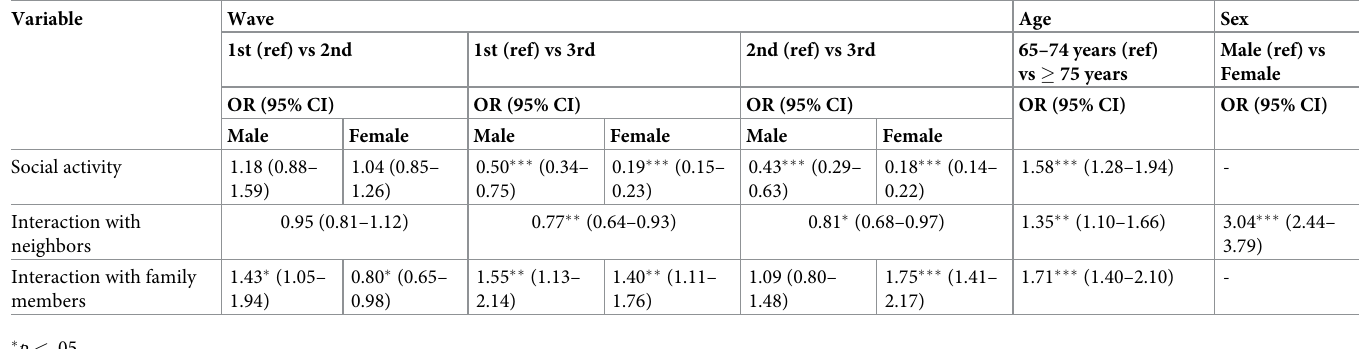
Table 2. Odds-ratio estimations from the generalized linear mixed modeling for categorical variables.